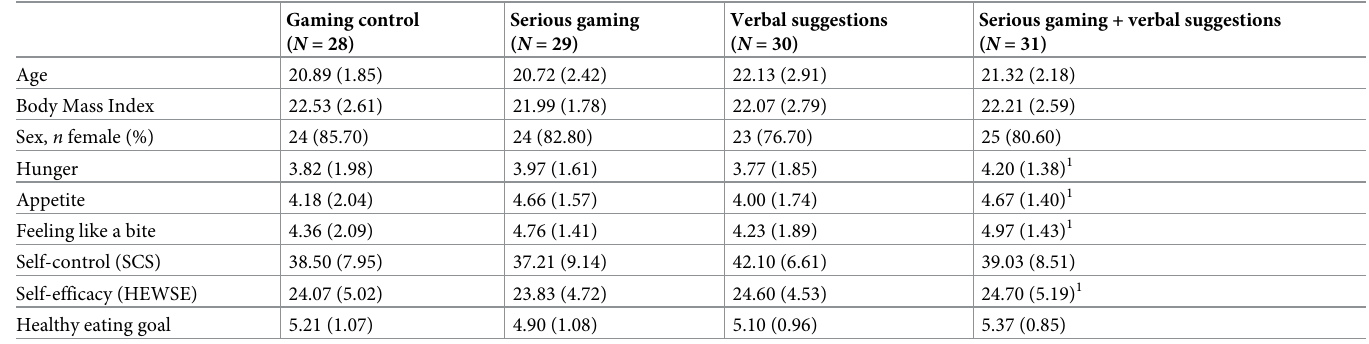
Table 1. Descriptives for the four conditions separately.